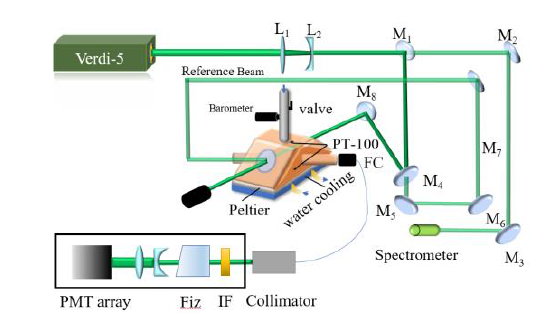
Fig. 2. Schematic diagram of the experimental setup. Dark green: laser beam (532nm), light green: reference beam (532nm), SC: scattering cell with Peltier